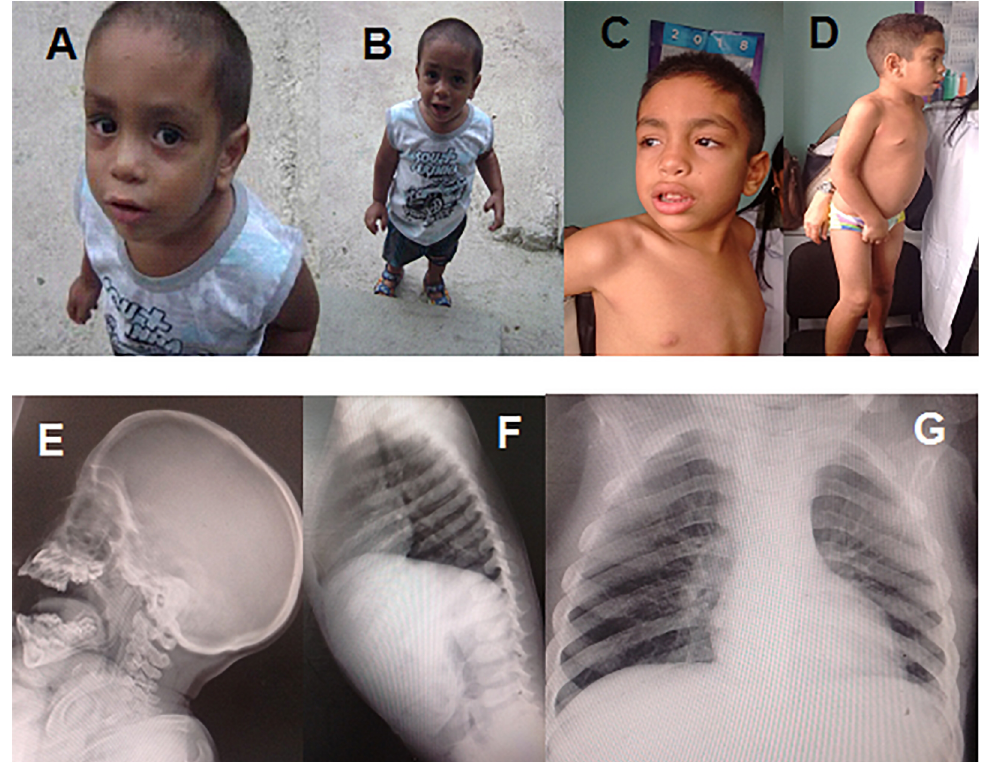
Figure 1. Clinical-radiological findings of the affected patient. A-B) Patient at 2 years old with discreet coarse facial features, broad nasal root without sinofris, depression of the nasal bridge with small nose and anteverted nares. Claw hand trend. C-D) Patient at 6 years with more marked dysmorphic signs. E-G) Mild signs of multiple